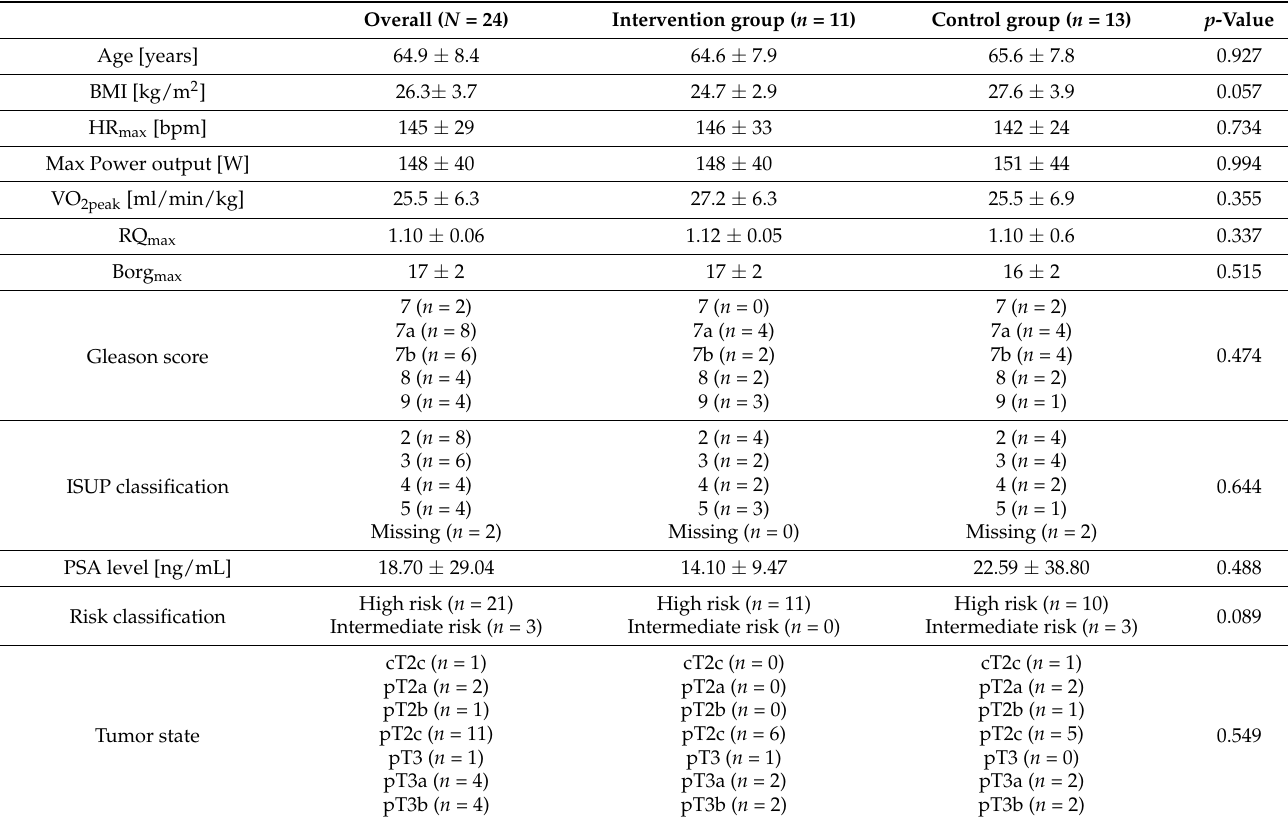
Table 1. Participants’ characteristics. Data are presented as mean ± SD. A t -test was used for group comparison of metric data and Pearson- χ 2 -test for normative data (Gleason score, International Society of Urological Pathology (ISUP) classification, risk classification according to D’Amico [43] and tumor state). RQ and Borg values are the maximal achieved values during the baseline graded exercise test (GXT). HR = heart rate, RQ = respiratory